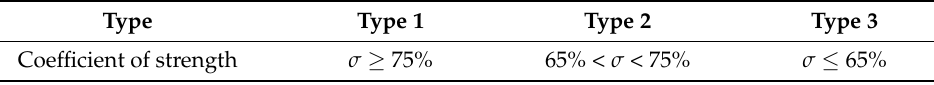
Table 2. Definition of welding performance types.